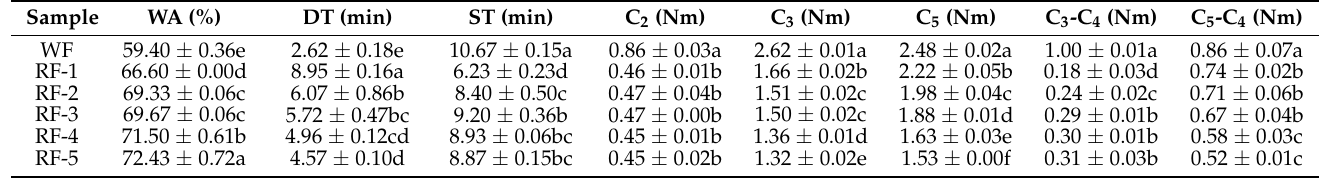
Table 3. Effect of highland barley flour with different particle sizes on the Mixolab properties of